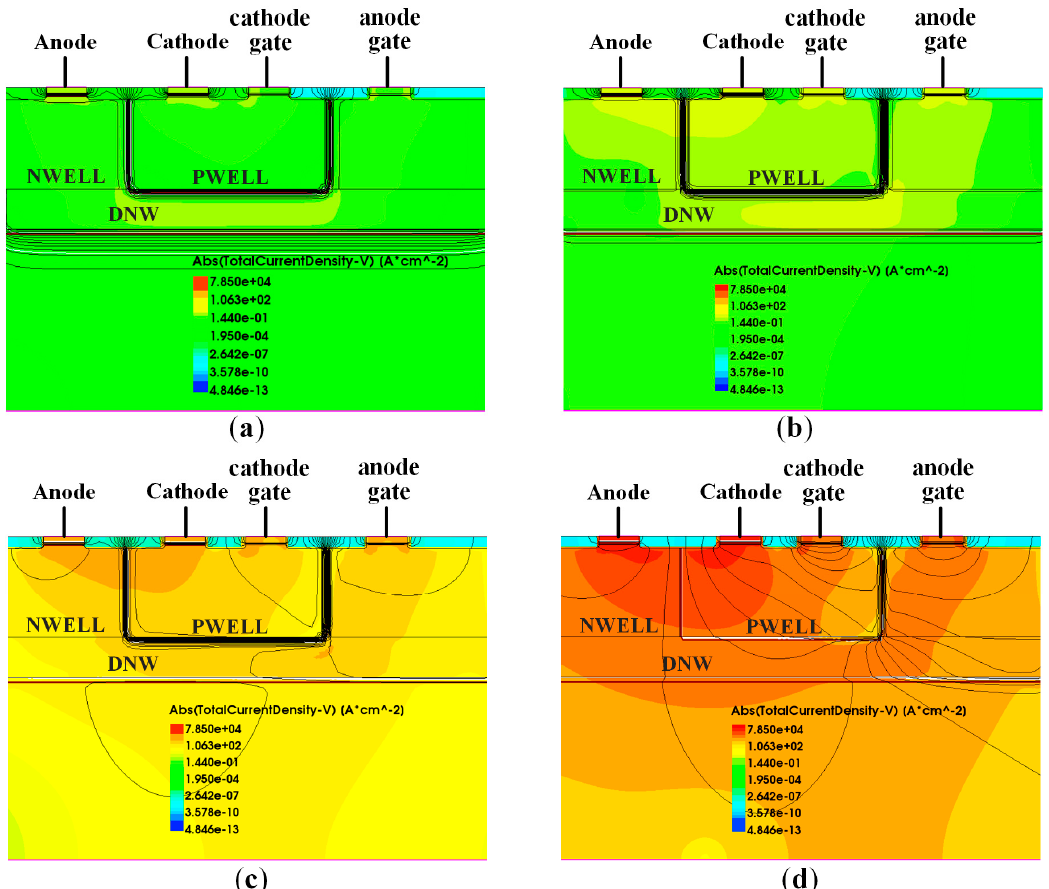
Figure 4. Total current density distributions at different current levels in proposed ERTSCR. ( a ) The trigger current flows along diode chain path; ( b ) the parasitic NPN and PNP transistors turn on; ( c ) the SCR path is triggered; and ( d ) the ESD current distribution after holding point.